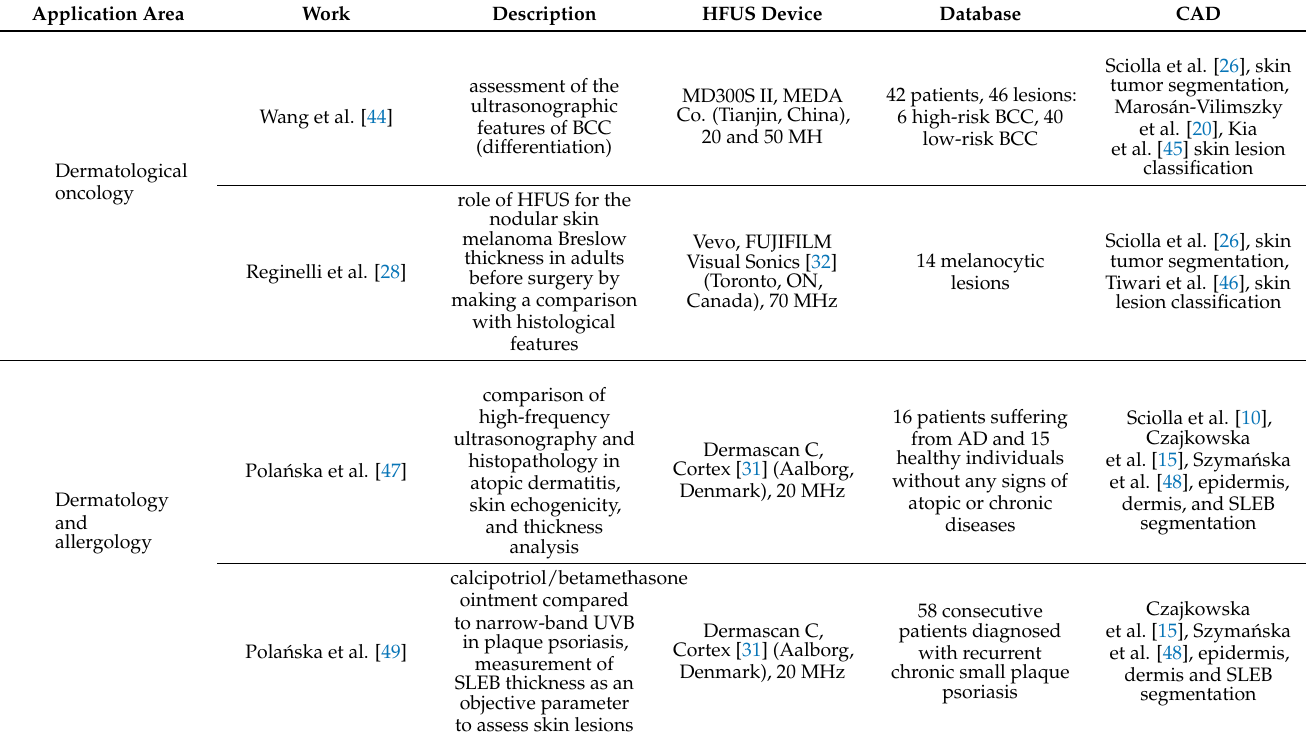
Table 2. Clinical applications of HFUS with dedicated CAD